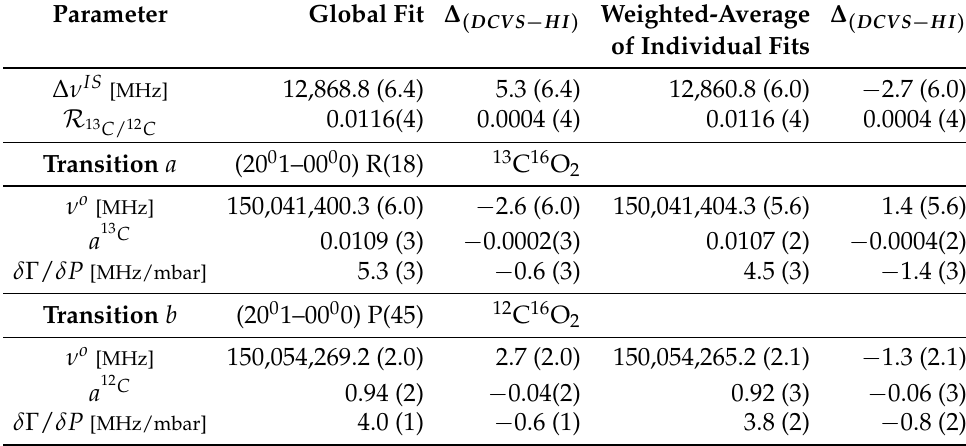
Table 1. ∆ ν IS and R 13 C / 12 C determinations from the measured spectral parameters of the (20 0 1-00 0 0) R(18) of 13 C 16 O 2 and (20 0 1-00 0 0) P(45) of 12 C 16 O 2 transitions from DCVS measurements @ 5005 cm − 1 and comparison with HITRAN database values [44]. Absolute frequencies are calculated by = N + f o + ∆ ν o ν o with N 0 order number of the OFC tooth transmitted by the M=0 FP mode 0 f r c t t and resonant with the 13 C 16 O 2 transition and f r and f o repetition rate frequency at the center of the c scan and offset frequency of the OFC, respectively. (Errors reported in parentheses). ∆ ( DCVS − HI ) are the differences between HITRAN database values and the present measured values for each tabulated parameter. The HITRAN database values are ν o = 150041403.1 (2) MHz, a 13 C = 0.01106 (1), δ Γ / δ P = 5.92 (5) MHz/mbar for the (20 0 1-00 0 0) R(18) transition of 13 C 16 O 2 and ν o = 150,054,266.5 (2) MHz, a 12 C = 0.9842 (9), δ Γ / δ P = 4.56 (4) MHz/mbar for the (20 0 1-00 0 0) P(45) transition of 12 C 16 O 2 . The frequency shift between them is ∆ ν IS = 12,863.5 (3) and the natural isotopic concentration ratio R 13 C / 12 C = 0.01123 (2). Errors of this differences take into account the error of the HITRAN values, which are added in quadrature to the measured